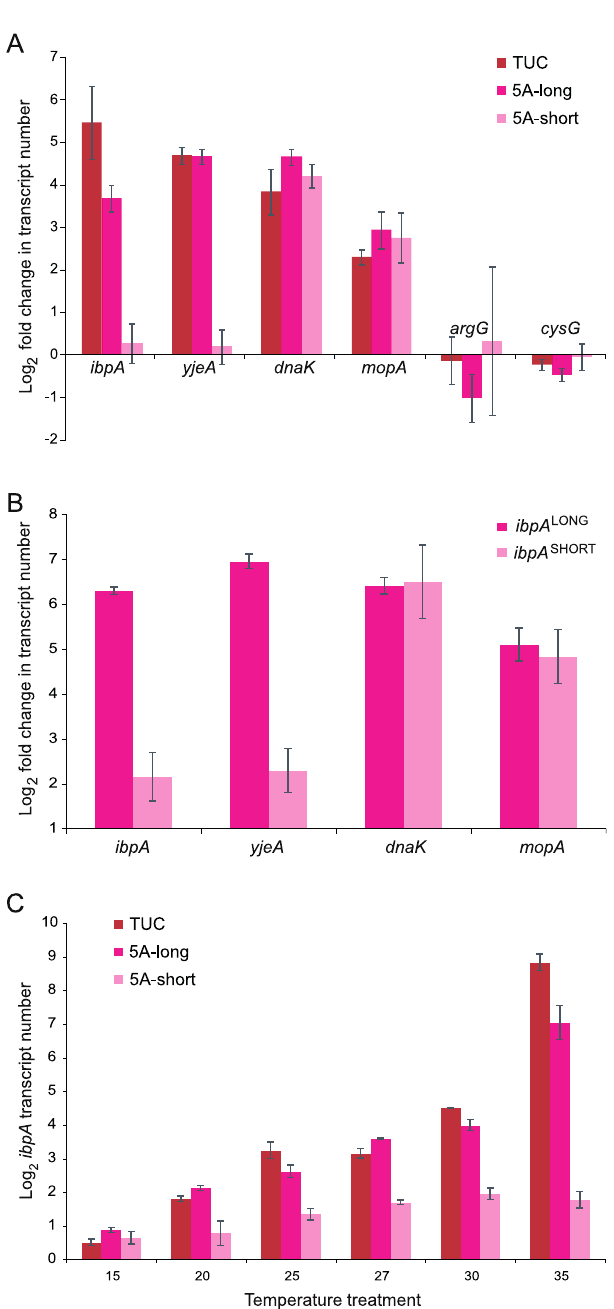
Figure 2. Response to Heat Treatment in Buchnera -Ap lines, for Genes Typically Up-Regulated in Response to Heat (A) Gene expression changes in response to heat treatment (35 8 C) as measured from a microarray experiment, including two control genes (argG and cysG) that did not show significant responses to heat treatment. Each bar represents the mean of technical and biological replicates of each line (four arrays/aphid line) 6 standard error. (B) Gene expression changes in response to heat (35 8 C) as measured with RT-qPCR using several A. pisum lines containing Buchnera with either short or long ibpA promoter alleles. For the long allele, n ¼ 4 (three lines), and for the short allele, n ¼ 2 (two lines). Error bars indicate means 6 standard errors. (C) Effects of exposure to different temperatures on ibpA expression for three aphid lines bearing Buchnera with different ibpA promoter alleles. The two 5A lines differ only in the single-base deletion affecting the length of the ibpA spacer; whereas TUC matches 5A-long for the ibpA promoter sequence, but shows other differences from 5A